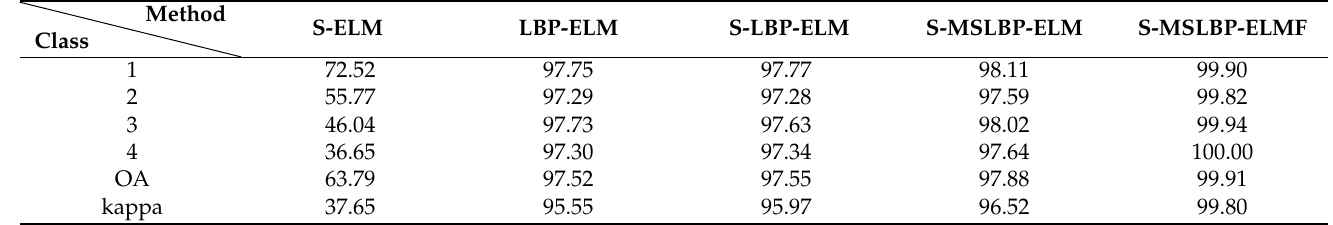
Table 5. Interpretation accuracies of different methods on wind-eroded desertification dataset (%).